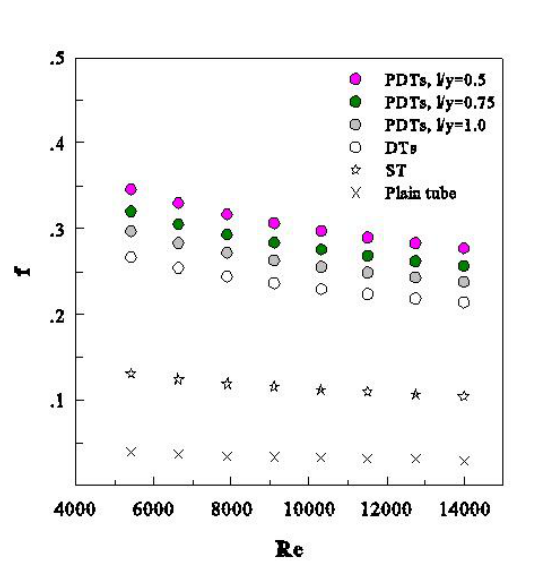
Figure 8: Friction factor against Reynolds number for PDTs at vari- ous cutting pitch ratios ( l / y = 0.5 , 0.75 and